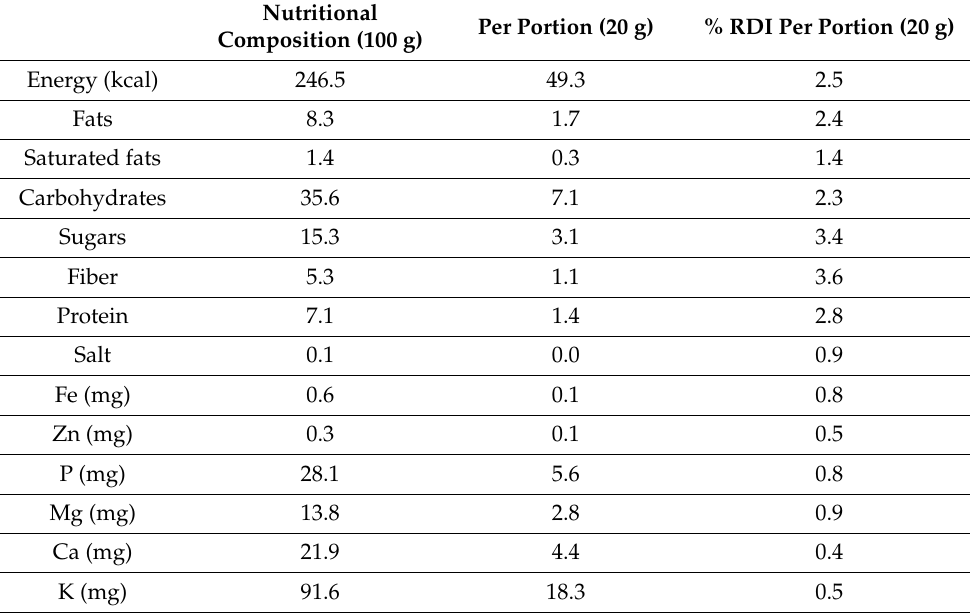
Table 4. Estimated nutritional composition of the product per 100 g and per portion and the RDI per portion.